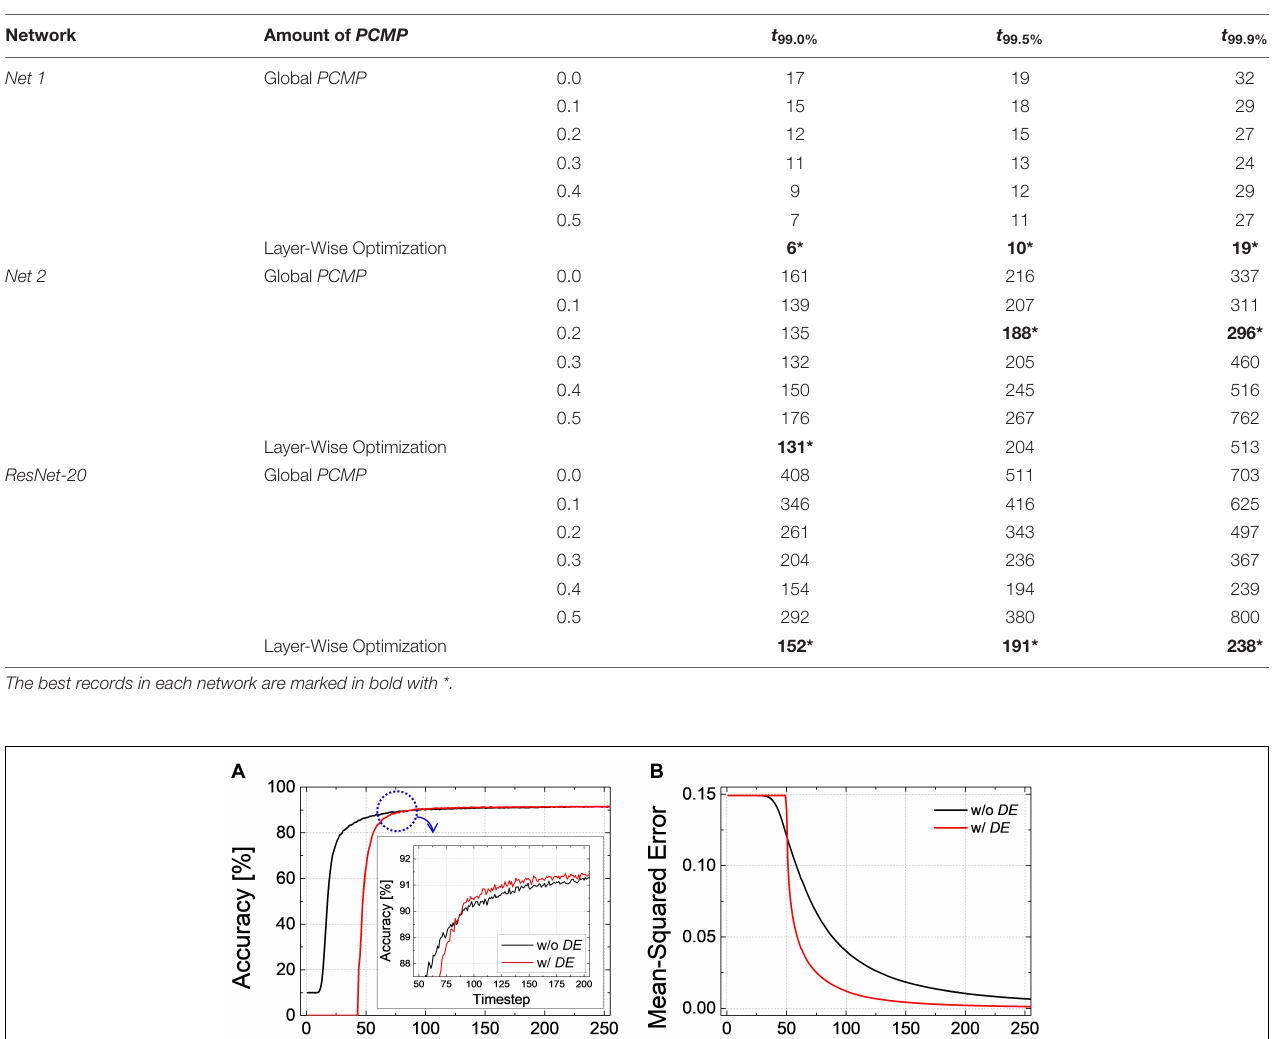
TABLE 2 | Latency of Global PCMP and Layer-Wise Optimization for Net 1, Net 2, and ResNet-20 . Network Amount of PCMP